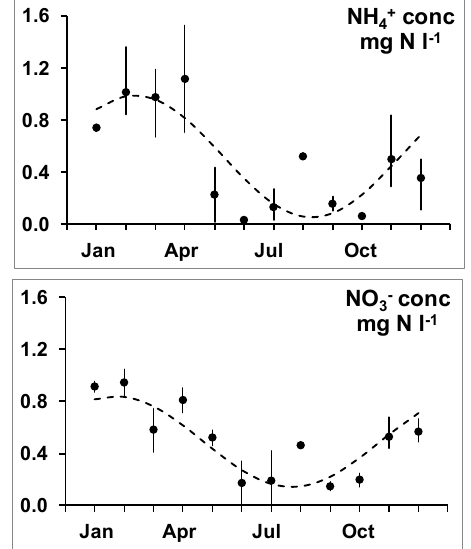
Fig. 4. Seasonal variation in concentrations of inorganic ions at Grillenburg. Points show monthly mean data, and bars show ranges. The parameters of the fitted sine function are shown in Table